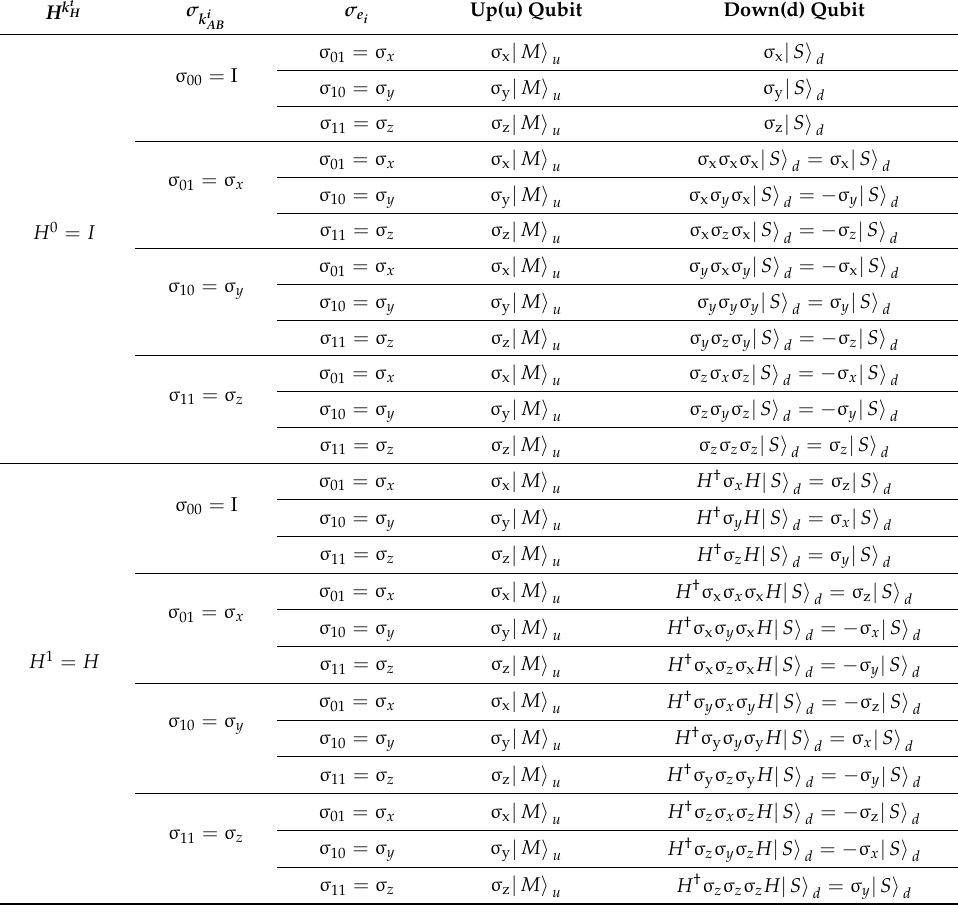
(cid:8) (cid:9) σ x , σ y , σ z in the encrypted